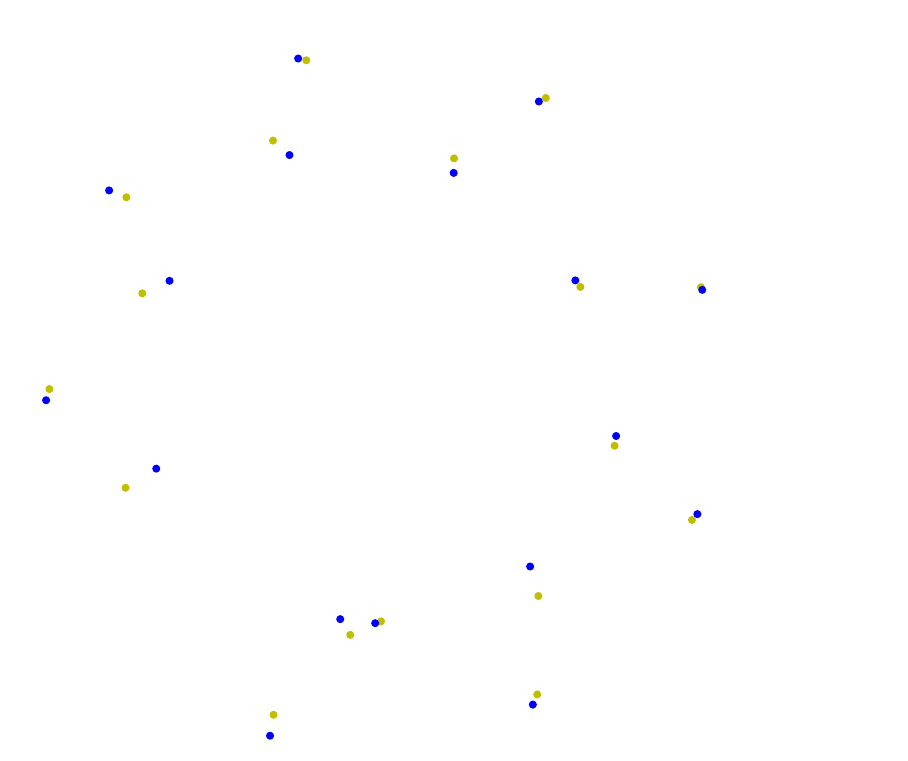
Figure 7. One sampled diffusion mean with the sampling scheme (blue configuration) together with estimated Fréchet mean (green configuration). The forward sampling scheme is significantly faster than the iterative optimization needed for the Fréchet mean on the landmark manifold where closed-form solutions of the geodesic equations are not